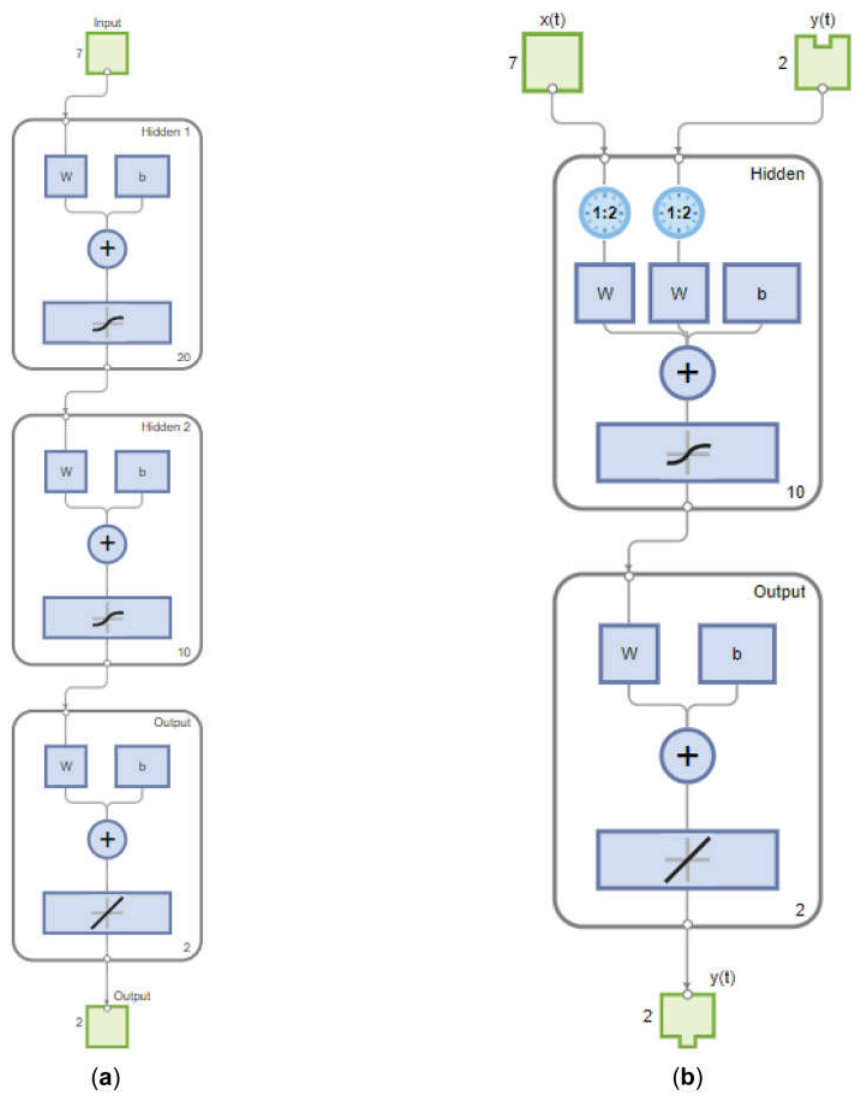
Figure 12. Architectures of the neural networks deployed in the study. ( a ) Feed-forward neural network with two hidden layers; ( b ) Narx implemented with a two-layer feed forward network.